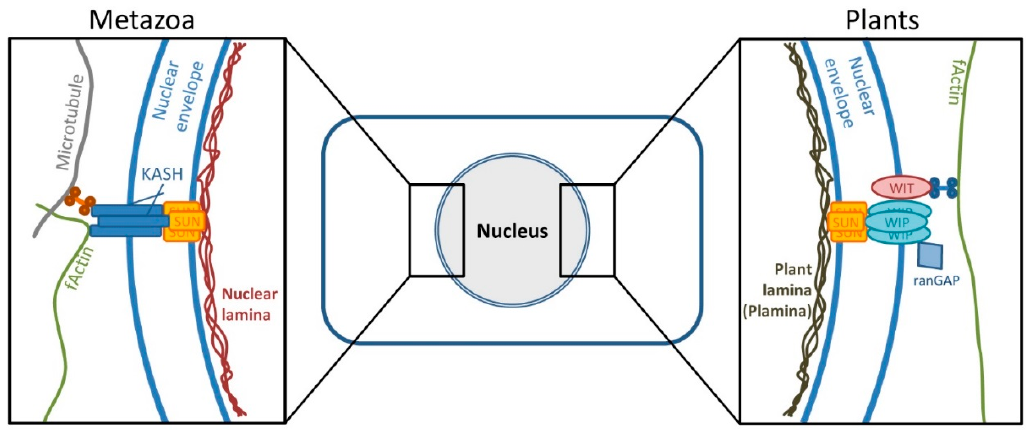
Figure 6. Comparison of selected structures from nuclear envelopes of metazoans and plants. Although not conserved on the level of amino acid sequence, several structures share functional redundancy. Depicted is the protein complex linking the nucleo- and cytoskeleton as well as the nuclear lamina/plant lamina (plamina). fActin: Filamentous actin; KASH: Klarsicht, ANC-1 and SYNE homology proteins; SUN: Sad1/UNC-84 proteins; WIP: WPP domain-interacting proteins; WIT: WPP domain-interacting tail-anchored